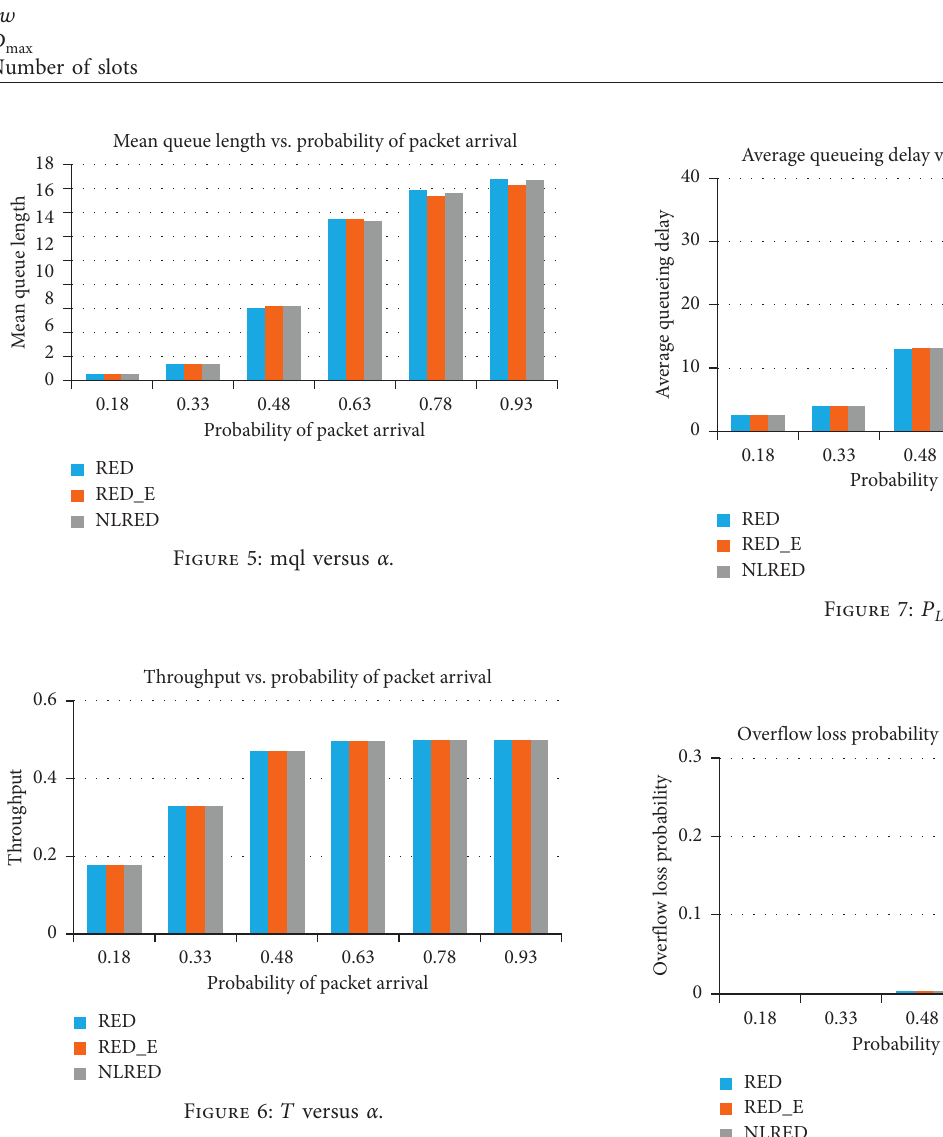
Figure 8: D versus α